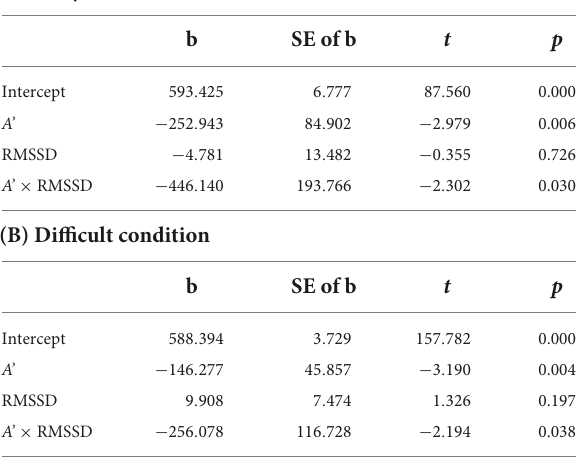
TABLE 4 Summary of models with the interaction